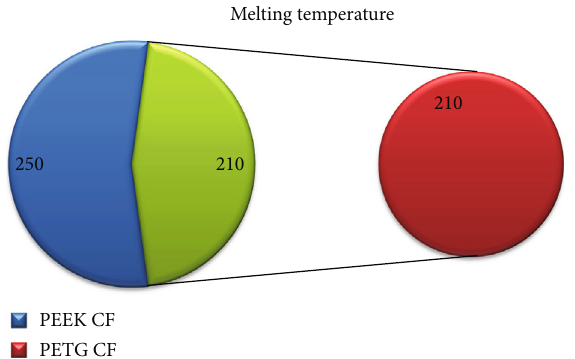
Figure 5: Comparison of the melting temperature of fi laments.